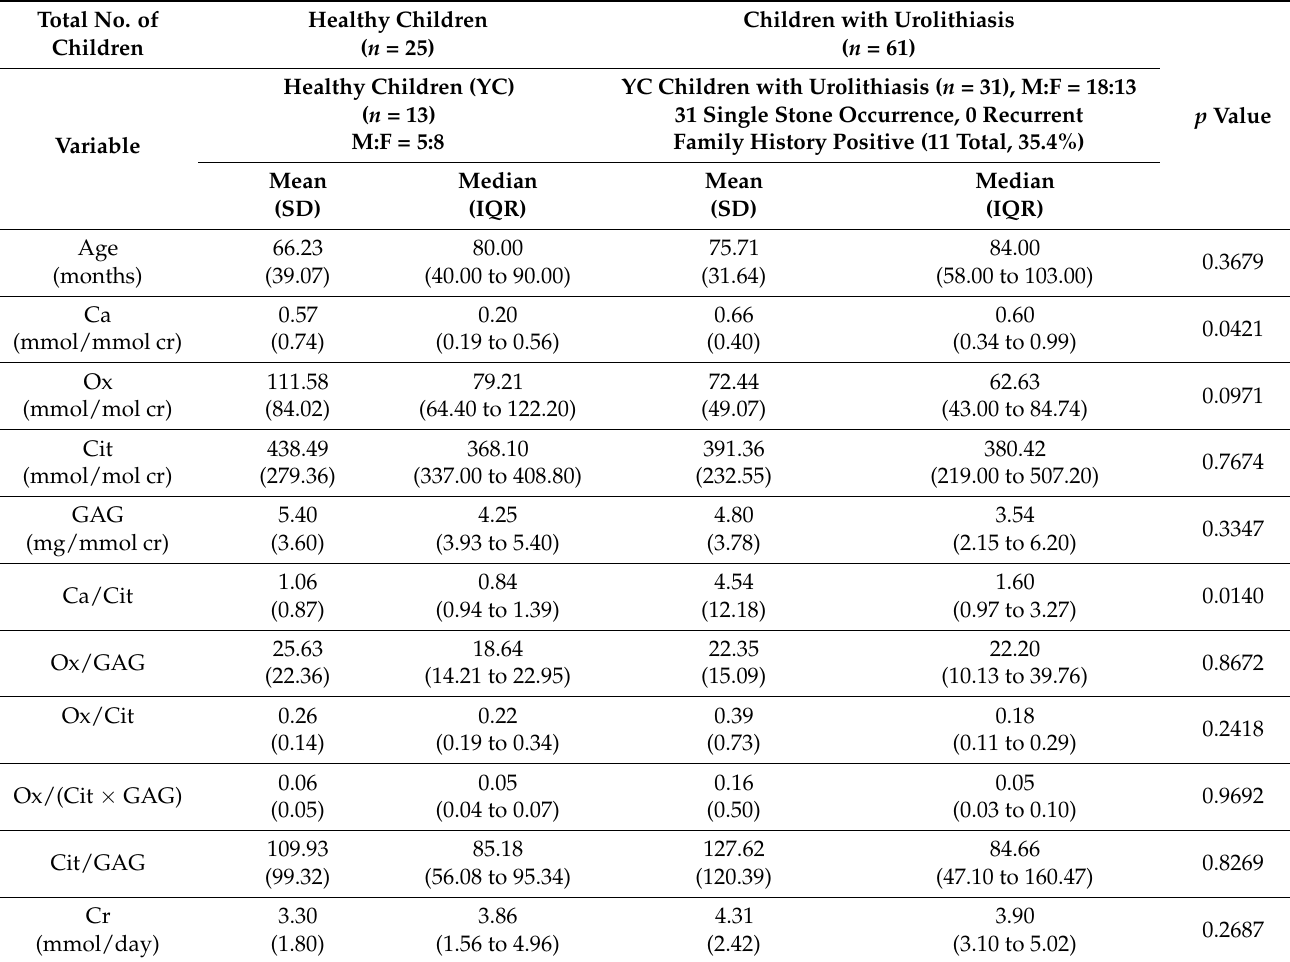
Table 1. Descriptive statistics and Mann–Whitney U-test for YC with urolithiasis and matched control group of healthy children (M = male, F = female).